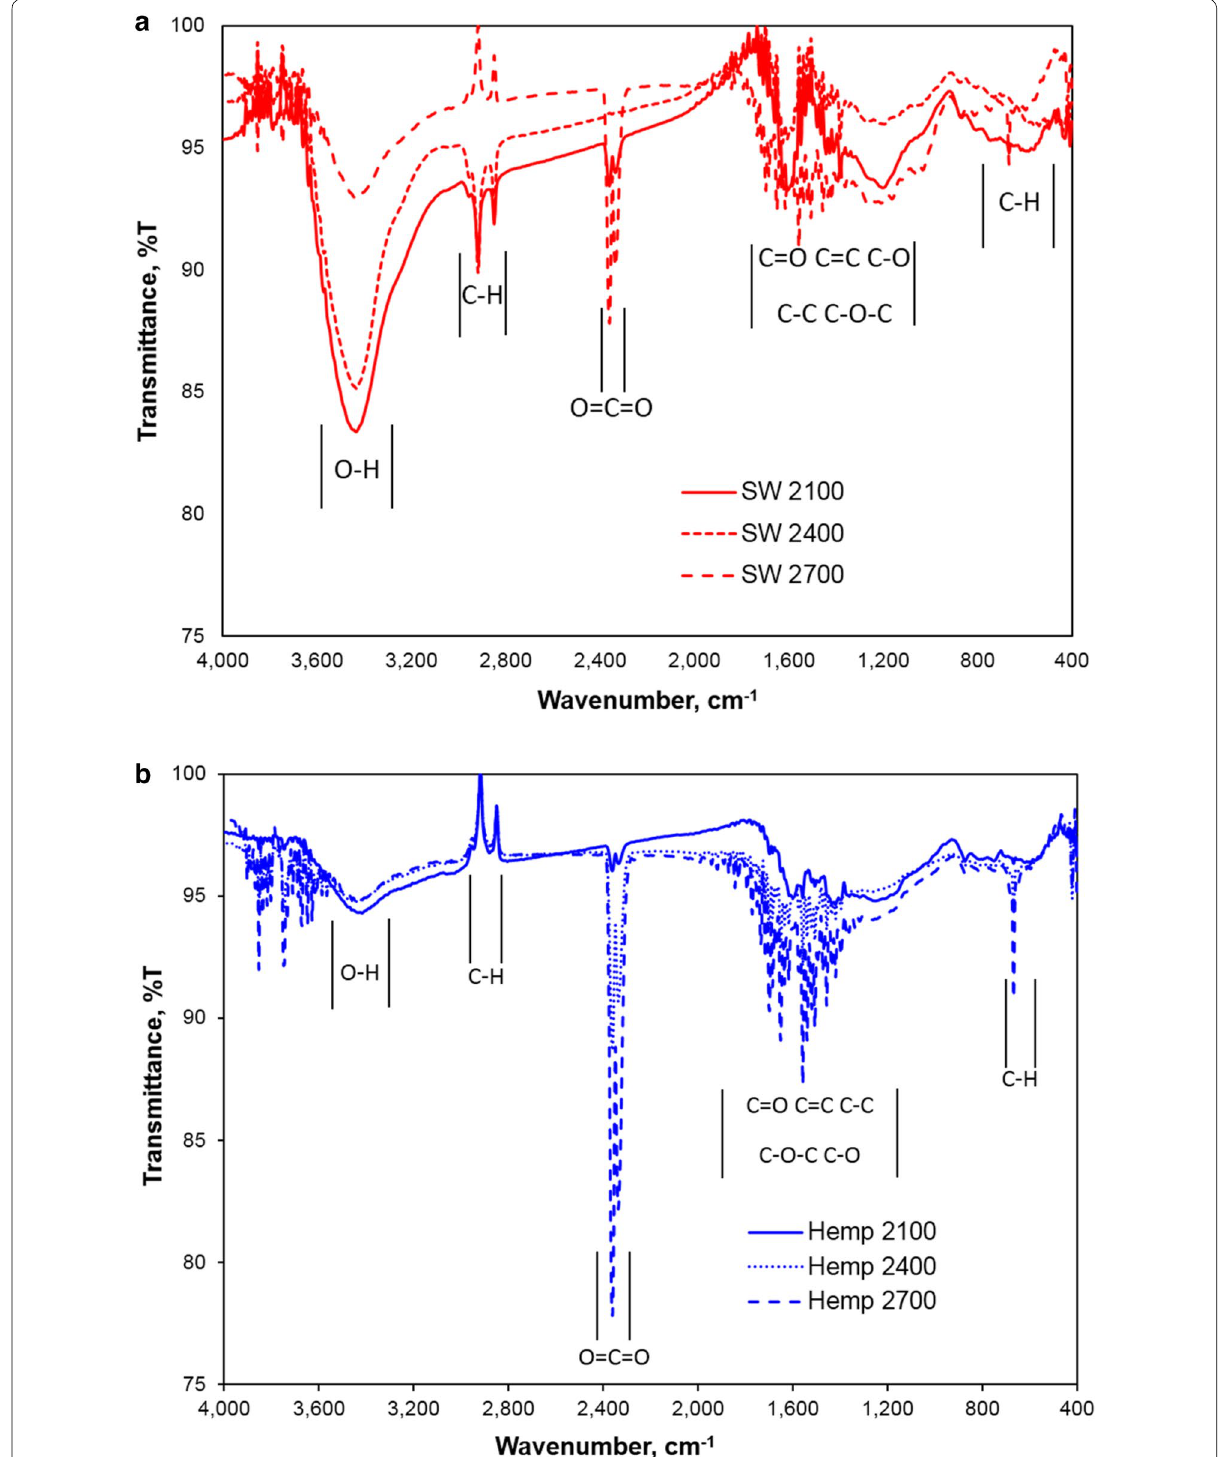
Fig. 5 FT-IR spectra corresponding to a softwood and b hemp biochars as a function of microwave power